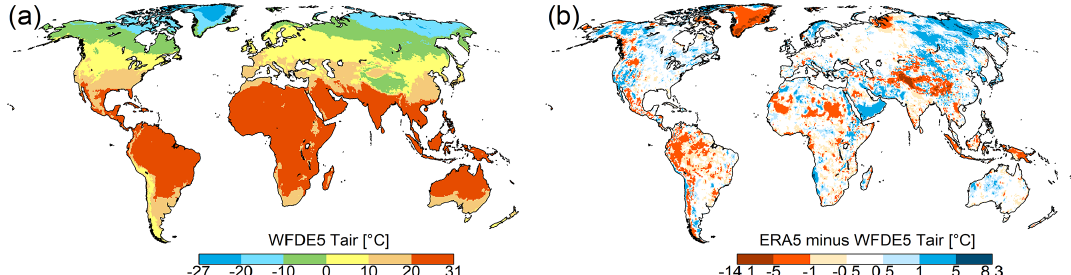
Figure A1. Long-term (1979–2016) average temperature of the climate forcings, displayed as absolute number for WFDE5 (a) and differ- ences to ERA5, computed as ERA5 minus WFDE5 (b) (all values are given in ◦ C).